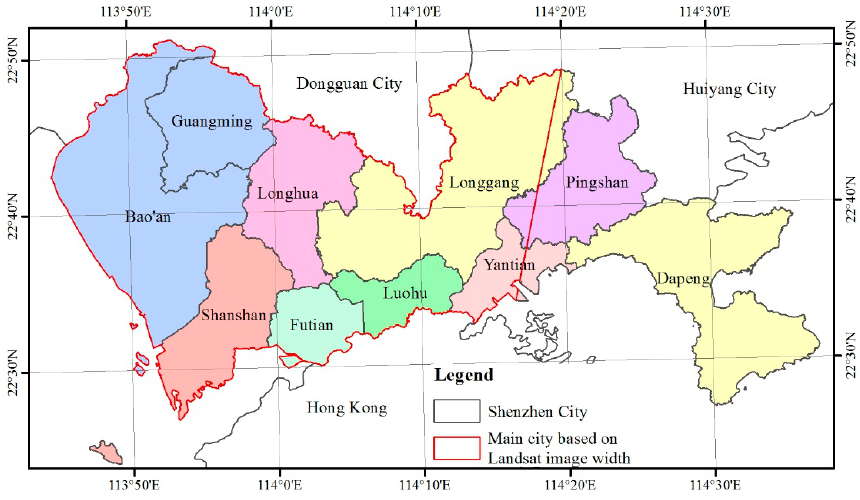
Figure 1. Location of the study area.